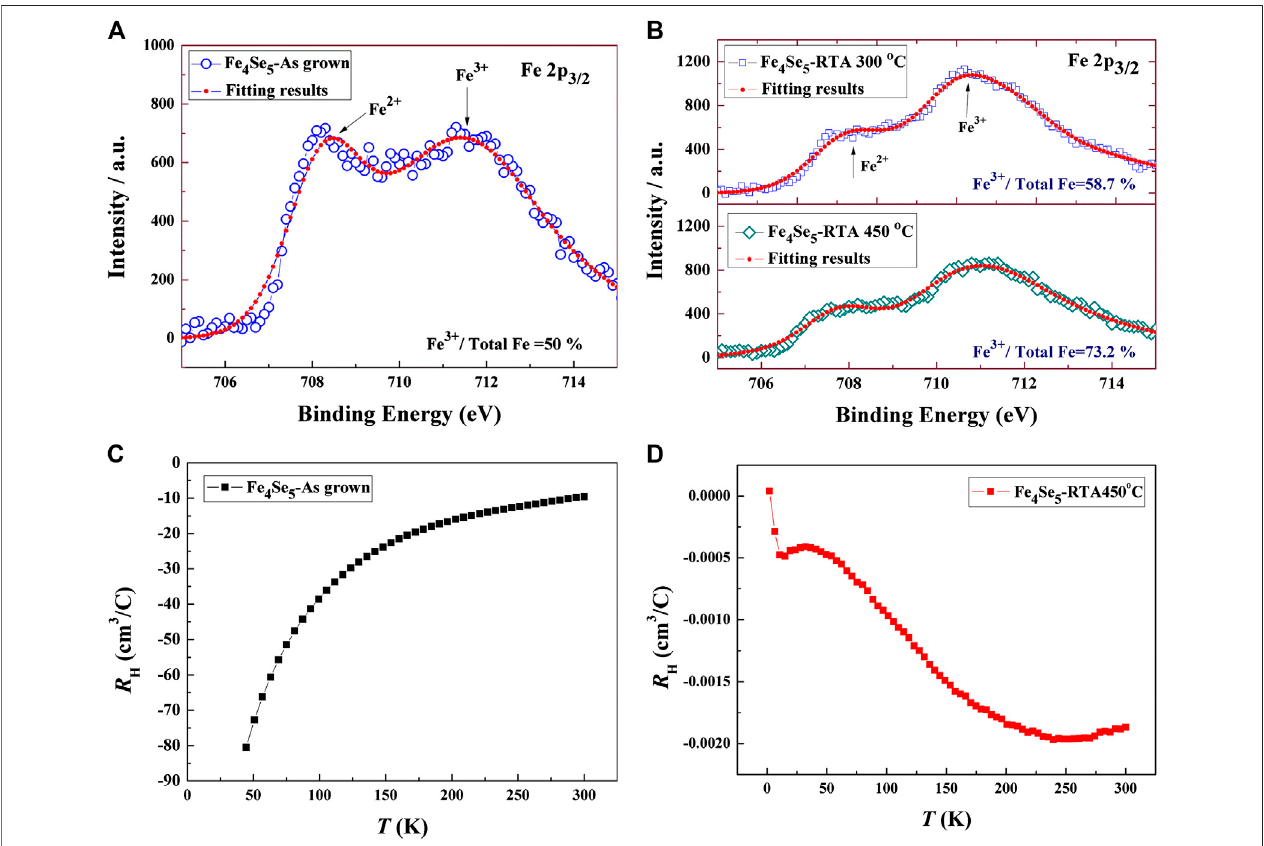
FIGURE 3 | Fe 2p3/2 spectrum of XPS analysis for (A) the as-grown Fe 4 Se 5 sample and (B) the 300 ° and 450 ° C RTA-treated Fe 4 Se 5 sample. The temperature- dependent Hall coef fi cient for (C) the as-grown Fe 4 Se 5 sample and (D) the 450 ° C RTA-treated Fe 4 Se 5 sample.